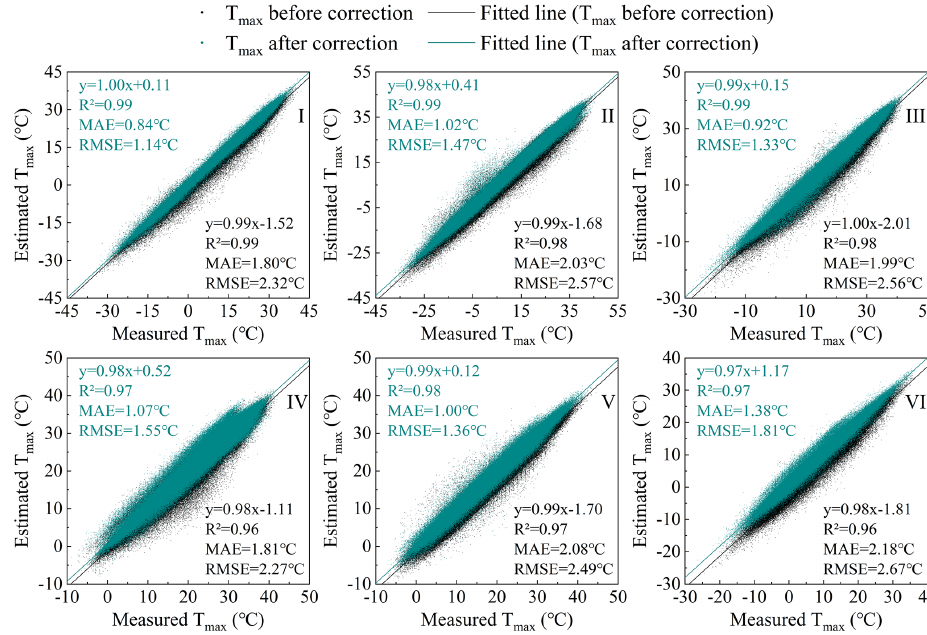
Figure 5. Validation of T max after